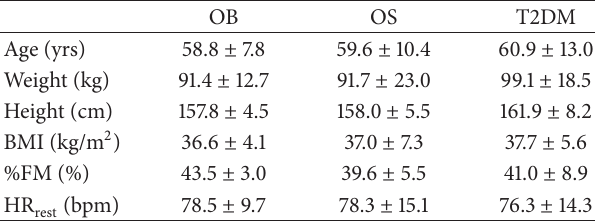
Table 1: Physical characteristics of patients.